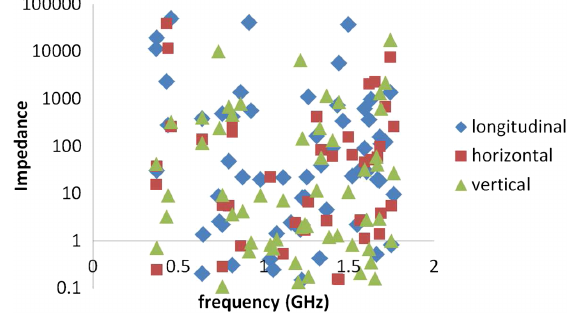
FIG. 28. Modal impedance for the final 4RCC